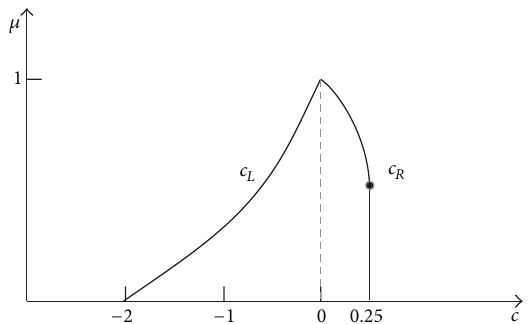
Figure 6: Membership function representing the span of the full 3D result of the fuzzy formula 𝐶 = 𝐴 − 𝐴 2